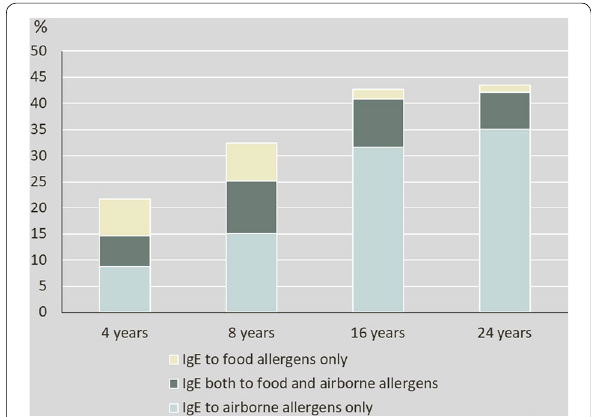
Fig. 2 Prevalence of IgE-sensitization to food* and airborne** allergens at ages 4, 8, 16 and 24 years in the population-based cohort BAMSE. *Peanut, soy, wheat, milk, egg and cod. **Timothy, birch, cat,